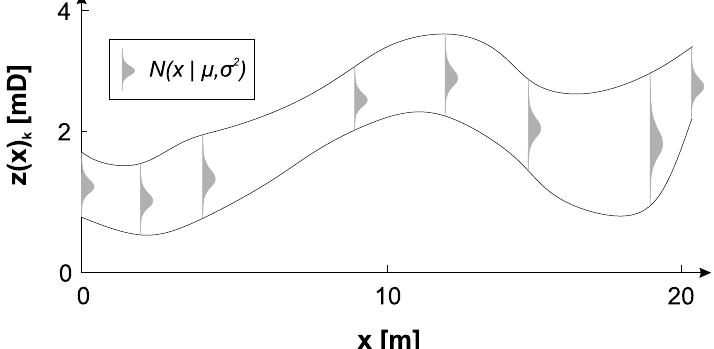
Figure 1. Conceptualization of a regionalized variable after [5] exemplary illustrated for the intrinsic